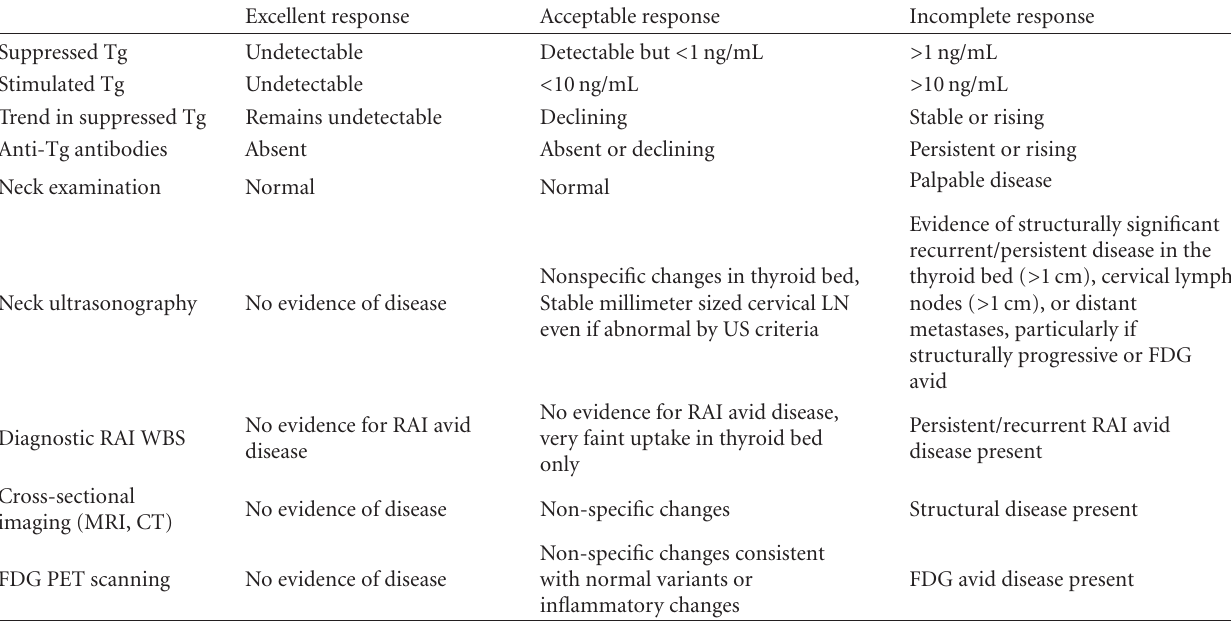
Table 1: Variables determined during follow-up that predict response to therapy (Tg → thyroglobulin) (adapted from [4]).